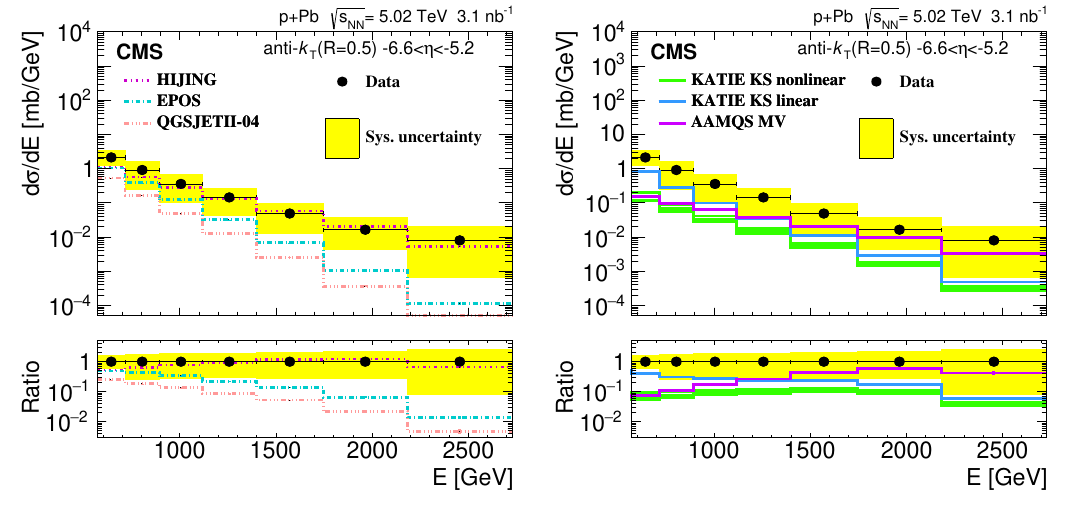
Figure 4 . Stable-particle-level di(cid:11)erential jet cross section as a function of jet energy measured in p+Pb collisions at 5.02 TeV, compared to the epos-lhc , hijing , and qgsjetii-04 (left), and katie and aamqs (right) predictions. The band associated with the nonlinear katie curve accounts for the 50{100% variation of the strength of the parton saturation e(cid:11)ects in this model.